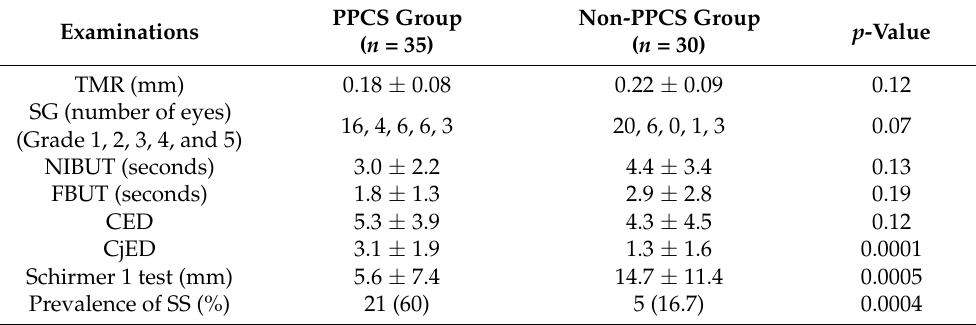
Table 1. Summary of the examinations of the ocular surface and the prevalence of Sjögren’s syndrome. PPCS Group Examinations